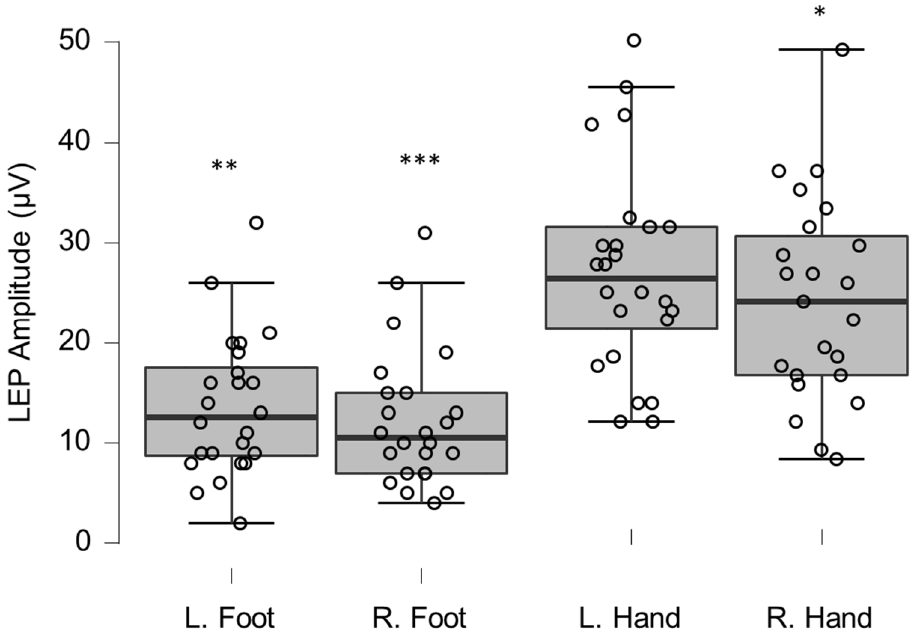
Figure 4. Box-plots for LEP amplitudes. Lower and upper box boundaries represent the 25th and 75th percentiles, respectively. The line inside the box represents the median and the lower and upper whiskers represent the 10th and 90th percentiles. Filled circles represent values ≥ two standard deviations outside reference values. *, **, and *** indicate statistically significantly lower median values compared to the reference material, with Bonferroni-corrected p -values corresponding to 0.05, 0.01, and 0.001, respectively. Table 3. LEP latencies in milliseconds for evoked potentials on left and right back of the hand or top of the foot. Reference material derived from in-house healthy subject normative data. * indi- cates a statistically significant differences to reference material with p -values corresponding to Bonferroni corrected 0.05.